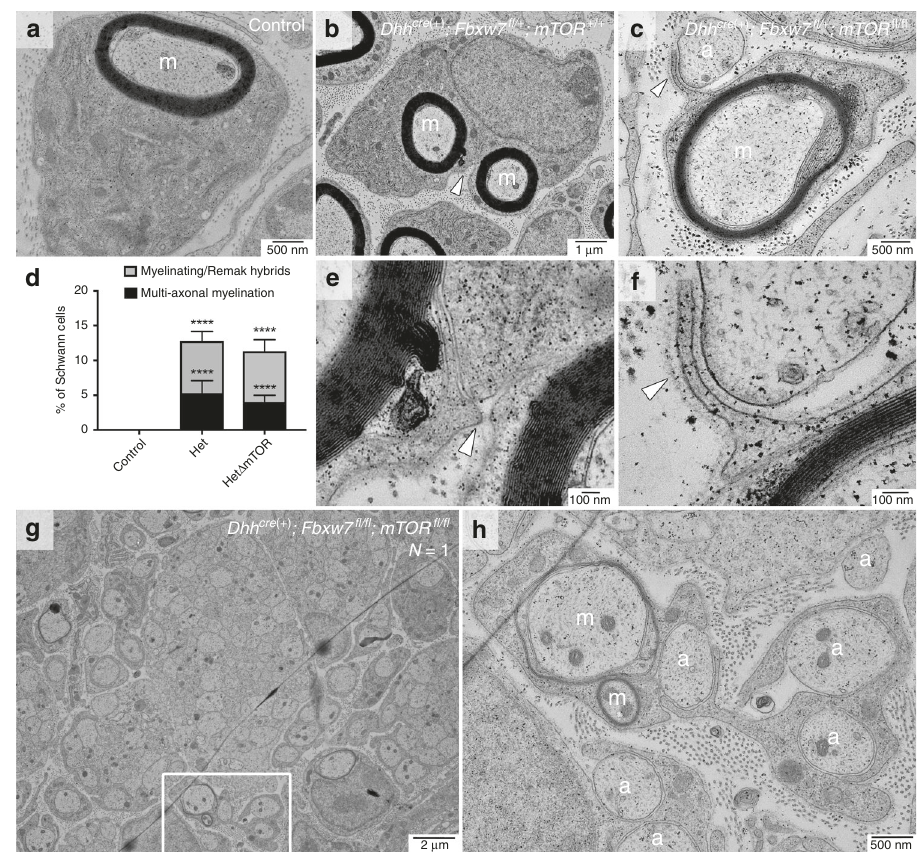
Fig. 5 The ensheathment capacity of myelinating SCs is independent of mTOR signaling. mTOR deletion in Fbxw7 mutant nerves failed to suppress aberrant SC-axon interactions. Apparent multi-axonal myelination and SCs that appeared to both myelinate and encompass multiple small non-myelinated axons were present in both Dhh cre ( + ) ;Fbxw7 fl / + ;mTOR + / + ( b , e ) and Dhh cre ( + ) ;Fbxw7 fl / + ;mTOR fl / fl (Het Δ mTOR) ( c , f ) nerves. Neither phenotype was ever observed in sibling controls ( a , d ; p < 0.0001(****); ANOVA). Tracing the BL ( e , f ; white arrows) suggested these behaviors were the acts of single SCs. Both phenotypes were also present in the sole Dhh cre ( + ) ;Fbxw7 fl / fl ;mTOR fl / fl (cKO Δ mTOR) animal we were able to collect ( g , h ). Asterisks above bars indicate comparisons with controls; comparisons between Dhh cre ( + ) ;Fbxw7 fl / + and Dhh cre ( + ) ;Fbxw7 fl / + ;mTOR fl / fl were not signi fi cant. P3: N = 4 control, 6 Dhh cre ( + ) ;Fbxw7 fl // + ;mTOR + / + , 5 Dhh cre ( + ) ;Fbxw7 fl / + ;mTOR fl / fl , 1 Dhh cre ( + ) ;Fbxw7 fl / fl ;mTOR fl / fl . m = myelinated axon; a = unmyelinated axon. Error bars depict